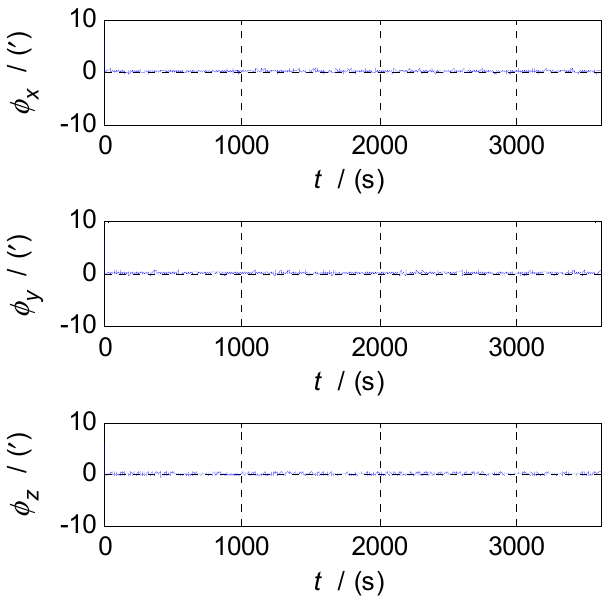
Figure 13. Attitude errors of SINS/CNS/GPS integration using complementary filter (CF).